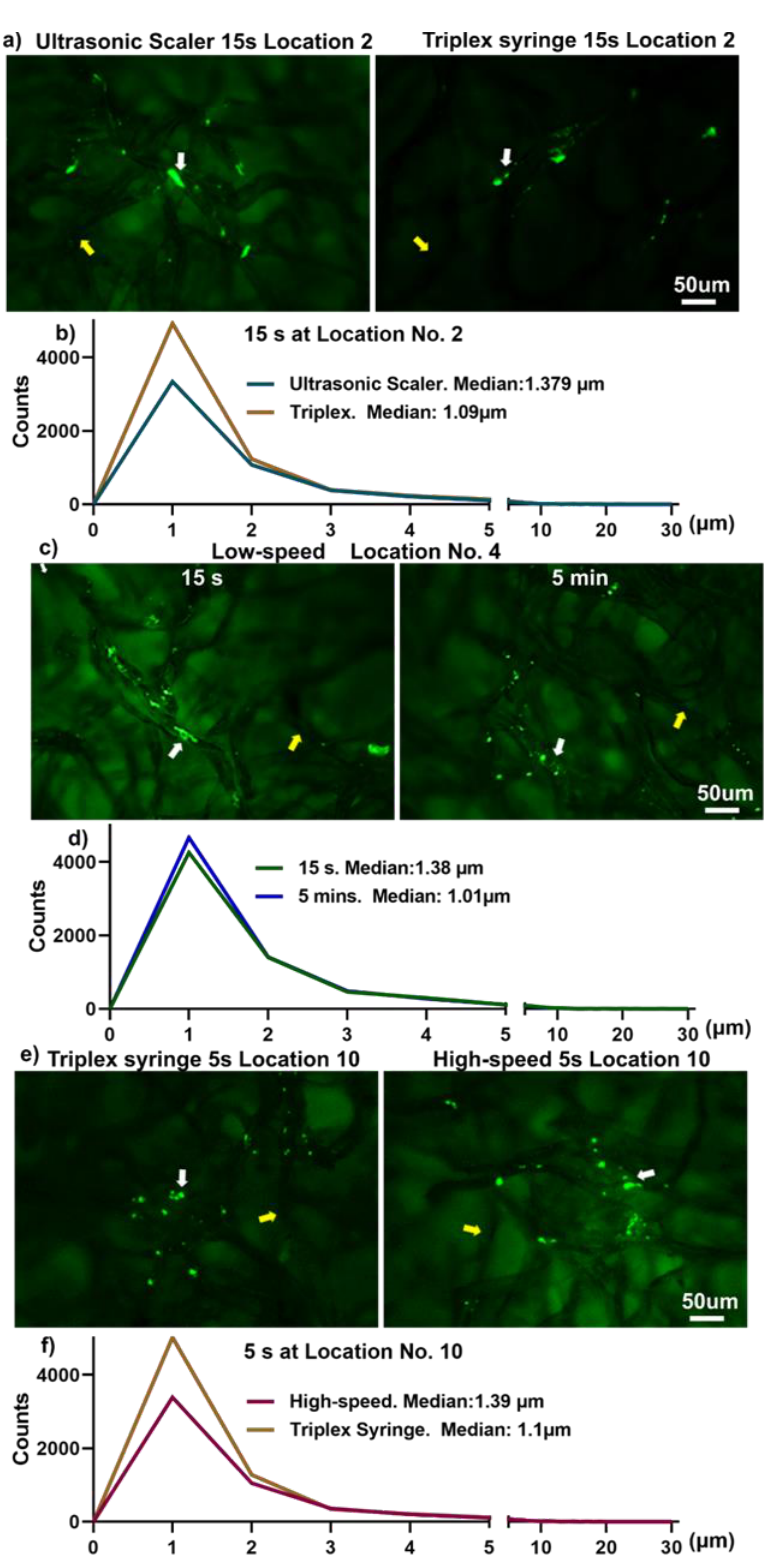
Figure 6. The visualisation (a, c, e) and histogram distributions (b, d, f) of aerosols particles on the filter paper fibres. White arrow: aerosol particles; yellow arrow: paper fibres.